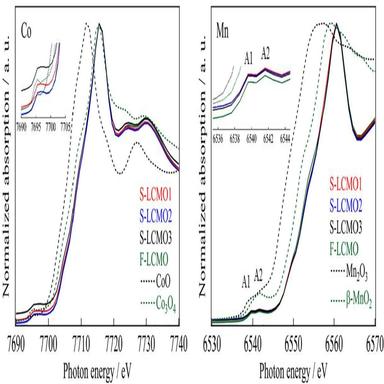
Normalized Co and Mn K-edge XANES spectra of S-LCMO1, S-LCMO2, S-LCMO3, and F-LCMO. Each spectrum is plotted together with CoO and Co3O4 or Mn2O3 and β-MnO2 as standards for comparison.